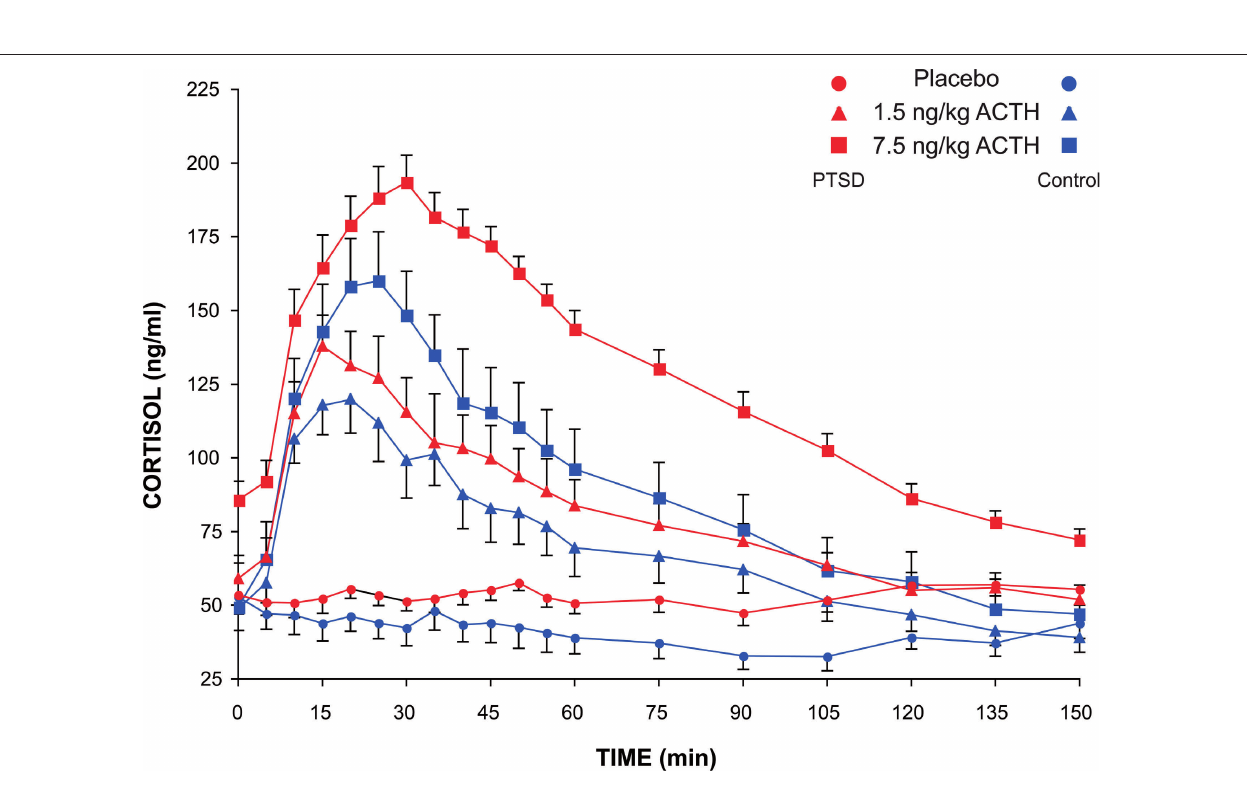
FIGURE 2 | Plasma cortisol concentration in PTSD and control subjects after ACTH infusion. Sampling occurred at 5-min intervals for 60 min and at 15-min intervals for the following 90 min. Mean and SEM values are plotted for each subject group and each dose of ACTH for the entire 150-min sampling period after